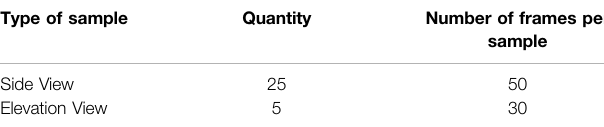
TABLE 1 | Sample information.